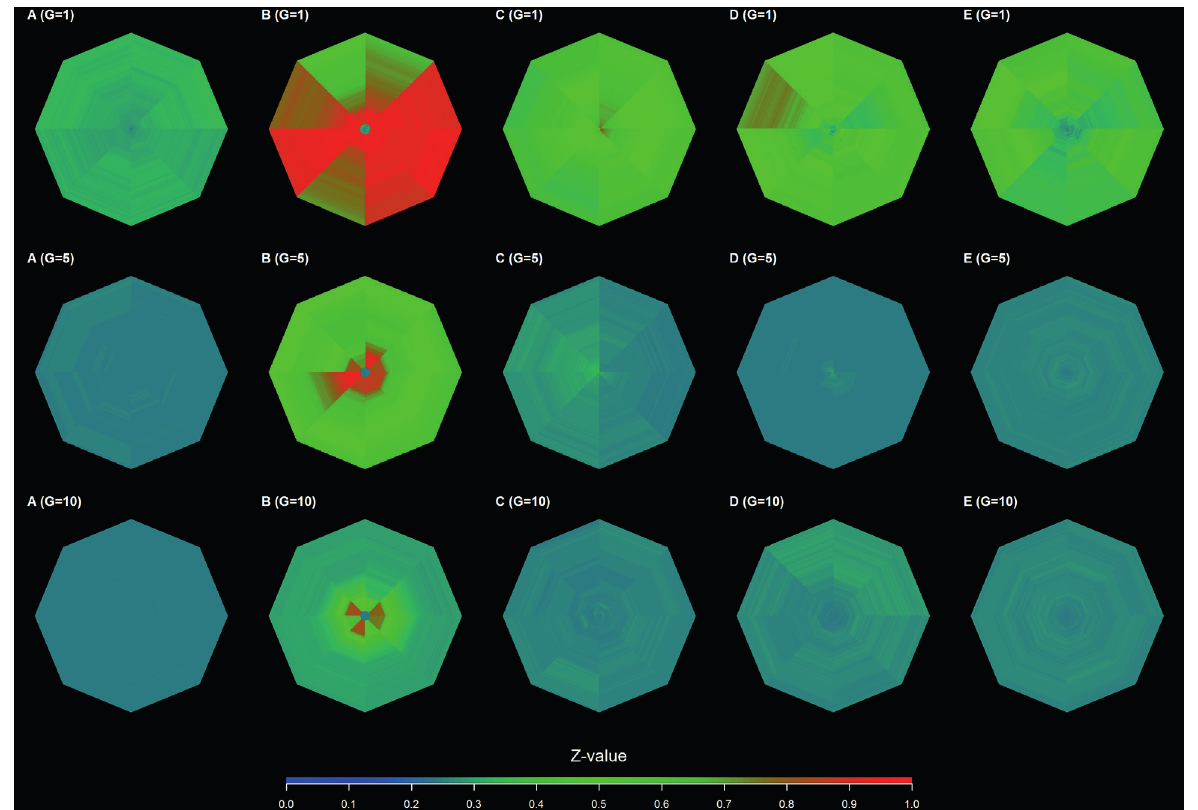
Figure 2 - Octagons indicating spatial and temporal dynamics of genetic patterns under different simulation scenarios. Each 45º sector corresponds to an area of the grid that was analyzed independently. Within each sector of the octagon, a line drawn from the center to the edge will cross the entire time span of the simulation (center represents time = 0, whereas border represents time = 1500). The Z-value (allelic fixation index) of each time interval (corresponding to 10 simulation time steps), of each sector, was plotted concentrically, forming 150 concentric layers colored according to the Z-value of the sector. Warmer colors indicate higher Z-value, therefore higher frequency of an allele over the space. Each octagon depicts the emerging genetic pattern according to different dispersal capacities (G = 1, G = 5, G = 10) and different scenarios of habitat restoration (A – E). Scenario A consists in a stable environment (no demographic expansion). Scenarios B and C have the entire domain under habitat restoration, whereas Scenarios D and E have only partial restoration. Scenarios B and D have rapid habitat restoration, while C and E have gradual habitat restoration. The graph was made for only one replica, using many replicas is not an interesting approach for this figure because summary statistics (e.g. means, medians, variance) for each sector will tend to be more similar as the number of replicates increases, preventing visualize the space-temporal pattern of dispersion of alleles. Allele surfing may occur in different sectors along the different replicates, because it does not have to occur always in the same sector (there are no processes related to specific